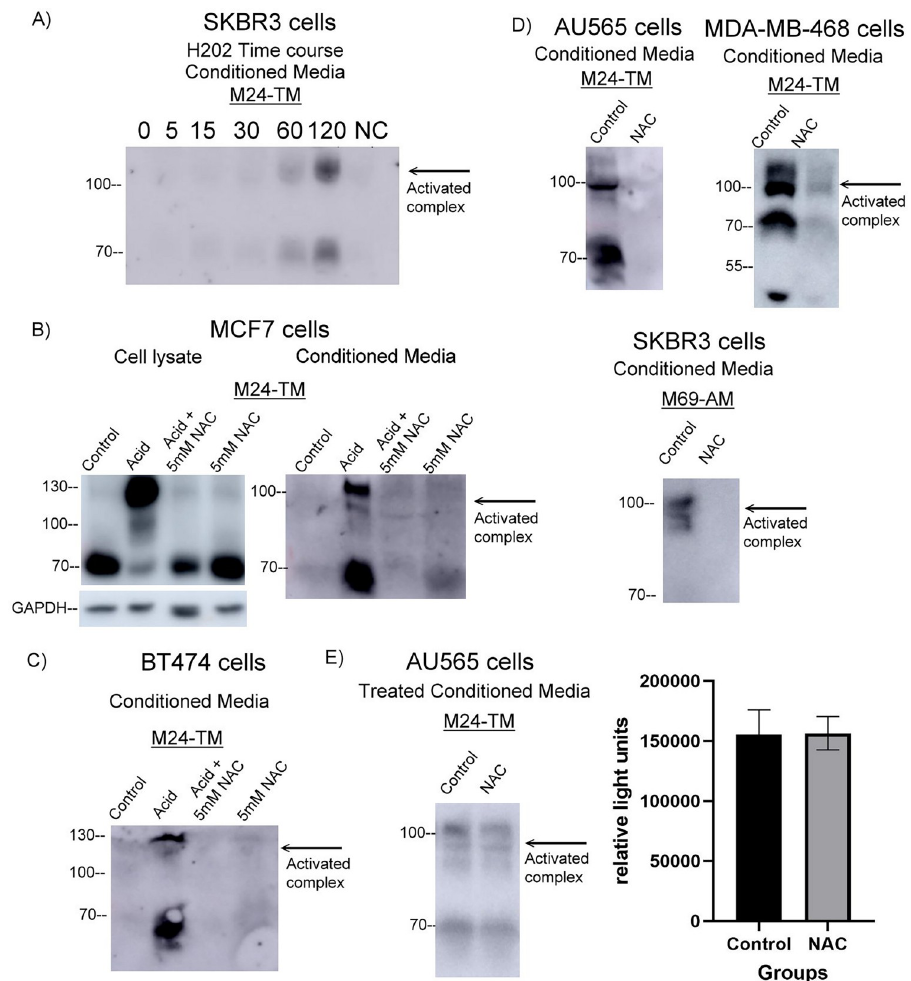
Fig 5. Investigating endogenous, cell stress, and acid-induced matriptase activation demonstrated those mechanisms were mediated ROS and could be inhibited by N-acetyl cysteine (NAC). A) SKBR3 cells were seeded in 35mm dishes and when ~80% confluent, washed twice with 1X sterile PBS and incubated for 3 hours with 5.4uM Lapatinib. Cells were then spiked with 10nm hydrogen peroxide for increasing amounts of time. Conditioned media was collected from the cells and analysed for levels of total and activated matriptase by the total matriptase (M24) antibody. B) MCF7 and C) BT474 cells were seeded in 35mm dishes and when 80% confluent. 5mM NAC was added to serum-replete media for 3 hours to pre-treat the cells. After pre-treatment, acid-induction buffer and 5mM NAC were added to cells either alone and in combination for 20 minutes. Cell lysates and conditioned media were collected in parallel and assayed for GAPDH as well as total and activated matriptase by the GAPDH and total matriptase (M24) antibody. D) MDA-MD-468, AU565, and SKBR3 cells were seeded in 35mm dishes and when ~80% confluent, incubated in 1ml serum-replete media with and without 5mM NAC for 24 hours. Conditioned media was collected from the cells and analysed for levels of total and activated matriptase by the total matriptase (M24) and activated matriptase (M69) antibody. Panels were representative of 3 biological replicates. E) AU565 cells were seeded in 35mm dishes and ~80% confluent, incubated in 1ml serum-replete media. Conditioned media was collected and 5mM NAC was added to experimental samples for 24 hours. The levels of activated matriptase were then assessed using total and activated matriptase antibodies. Panels were the highest quality representative of 4 biological